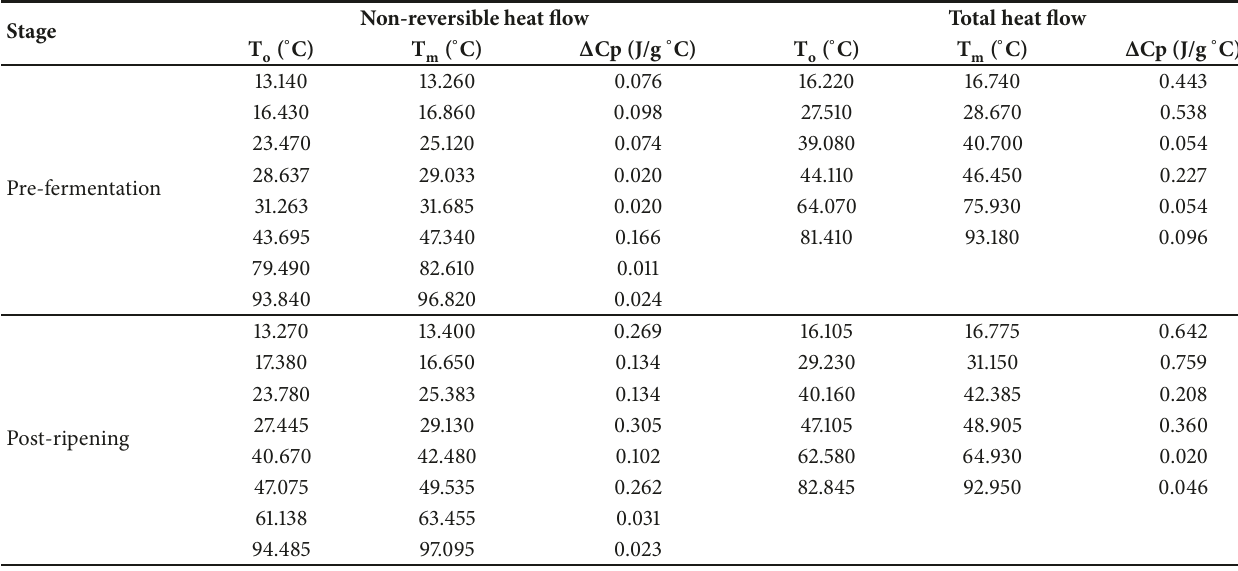
Table 3: Transitions of nonreversible and total heat flow, onset temperature of the endothermic peak (T specific heat ( Δ Cp) of lipid fractions of salami of treatment Ls-Sc + in the prefermentation and postripening